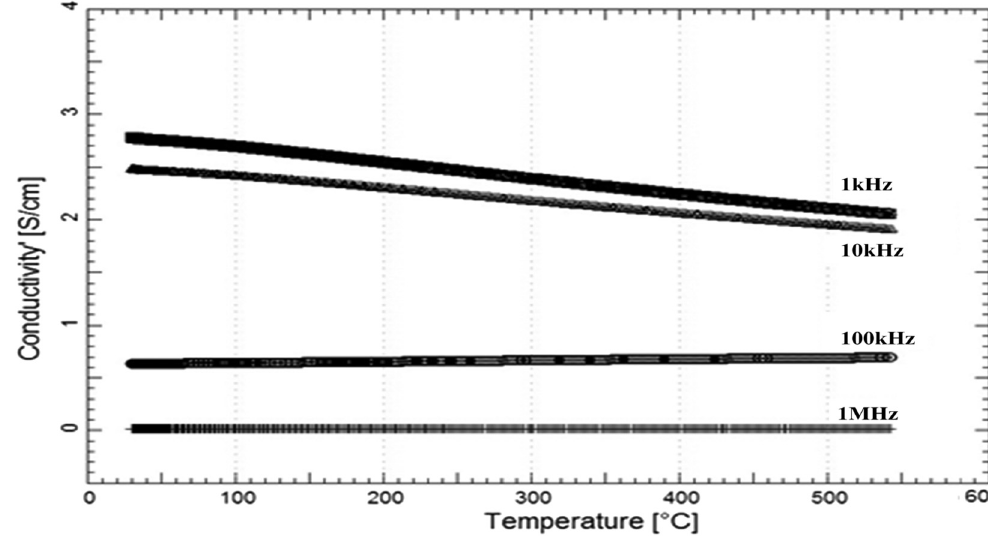
Figure 6: AEPA graphs of the composition - dependent change in conductivity - received 50% Ni - coated Fe – 25% Co